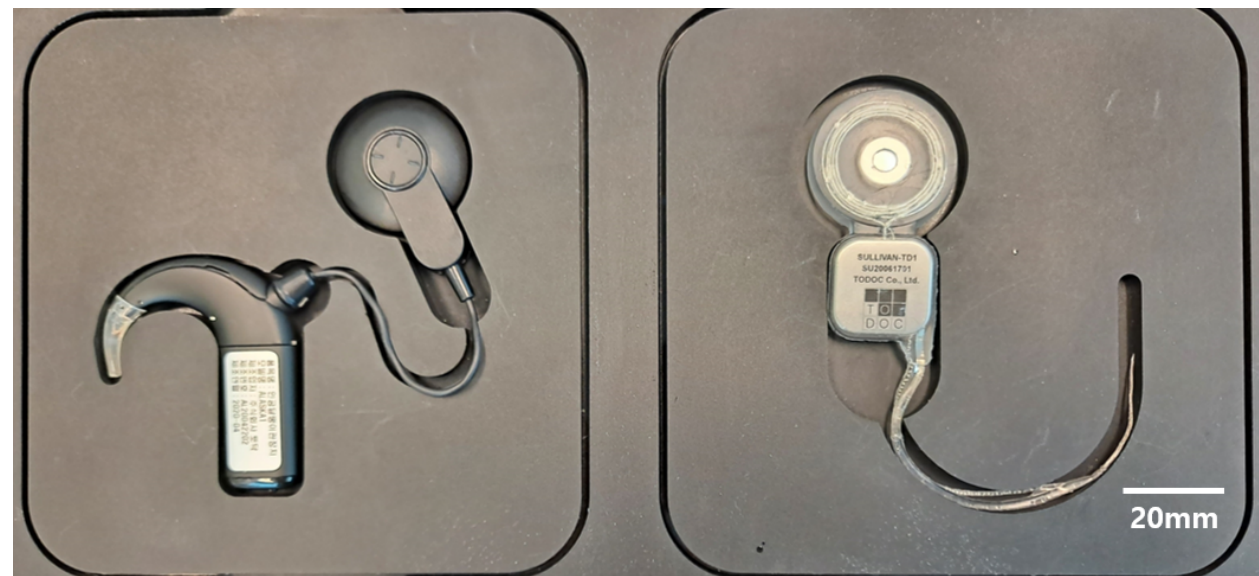
Figure 10. TODOC’s 32-Channel Cochlear Implant Sound Processor (Left ) and Implantable Pulse Generator ( Right ). The 32-channel cochlear implant system consists of 32-channel neural stimulation and recording IC, titanium-based hermetic package, and sound processor with wireless power and signal transmission